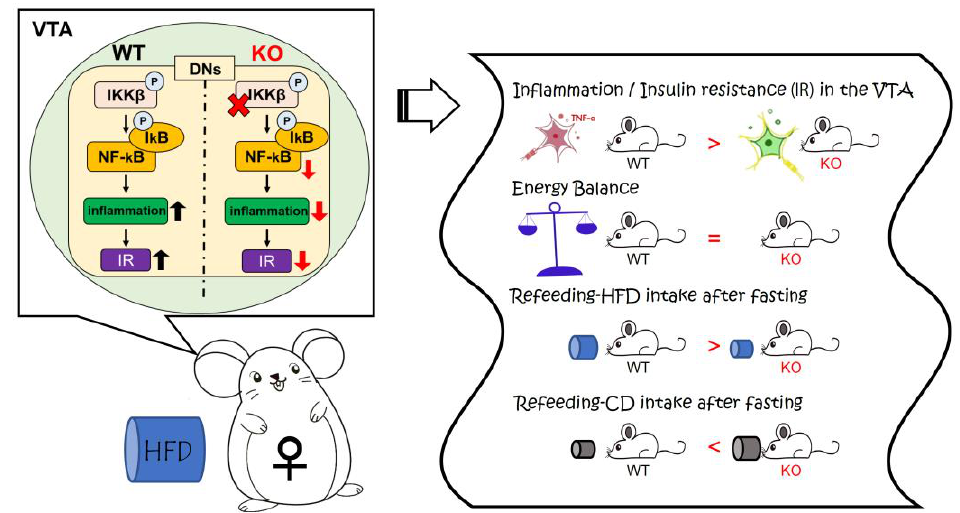
Figure 7. Schematic illustration of the regulation of feeding behaviors by IKK β signaling in the VTA. IR: insulin resistance; DNs: dopamine neurons.